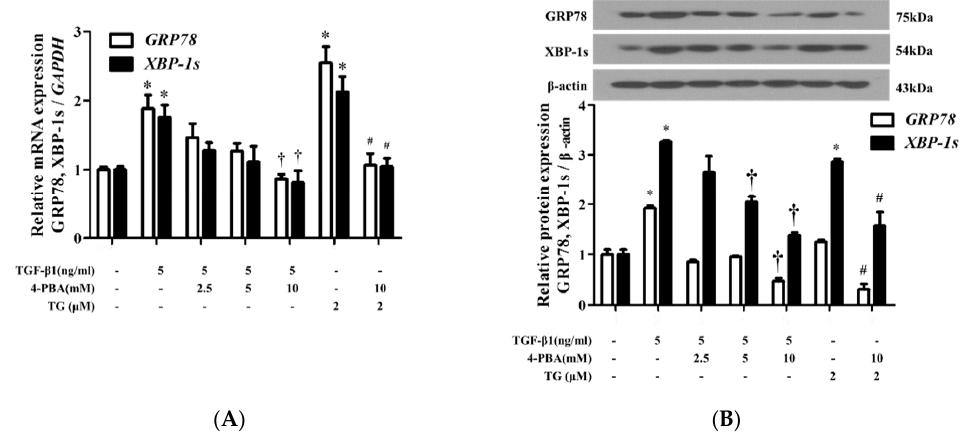
Figure 2. 4-PBA suppresses the expression of TGF- β 1-induced ER stress-related markers in nasal fibroblasts. ( A ) Nasal fibroblasts were pre-treated with 4-PBA (2.5-10 mM) for 1 h and stimulated with TGF- β 1 (5 ng / mL) for 24 h. The mRNA levels of GRP78, XBP-1s were measured by Real-time PCR. Data were normalized to GAPDH expression. ( B ) Protein levels of GRP78, XBP-1s were assessed by Western blotting after 48 h of TGF- β 1 treatment. Cells treated with the ER-stress inducer, TG (2 nM) were used as a positive control. Data are presented as mean ± SEM and are representative of at least three independent experiments. * p < 0.05 vs. control, † p < 0.05 vs. TGF- β 1 treatment, # p < 0.05 vs. TG